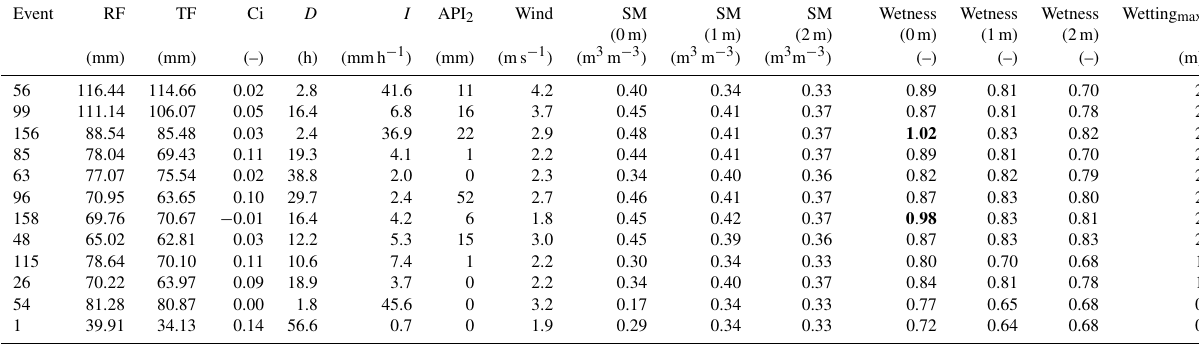
Table 2. Characteristics of 12 large/long rainfall events considered in this analysis.